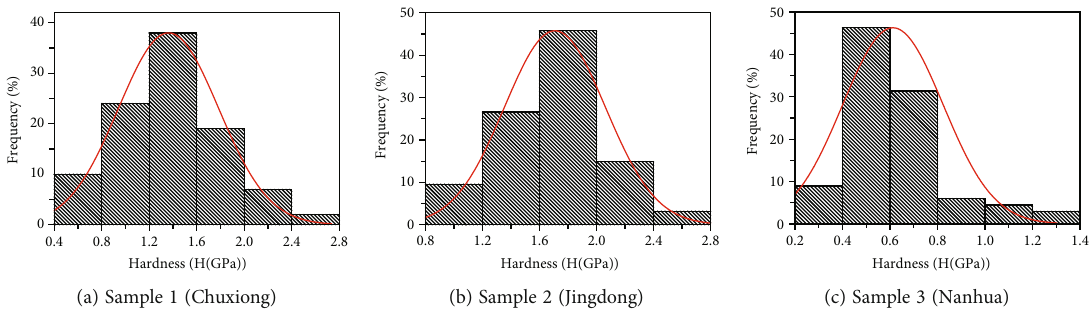
Figure 14: Normal distribution diagrams of hardness of Yunnan red-bed mudstone in three regions.